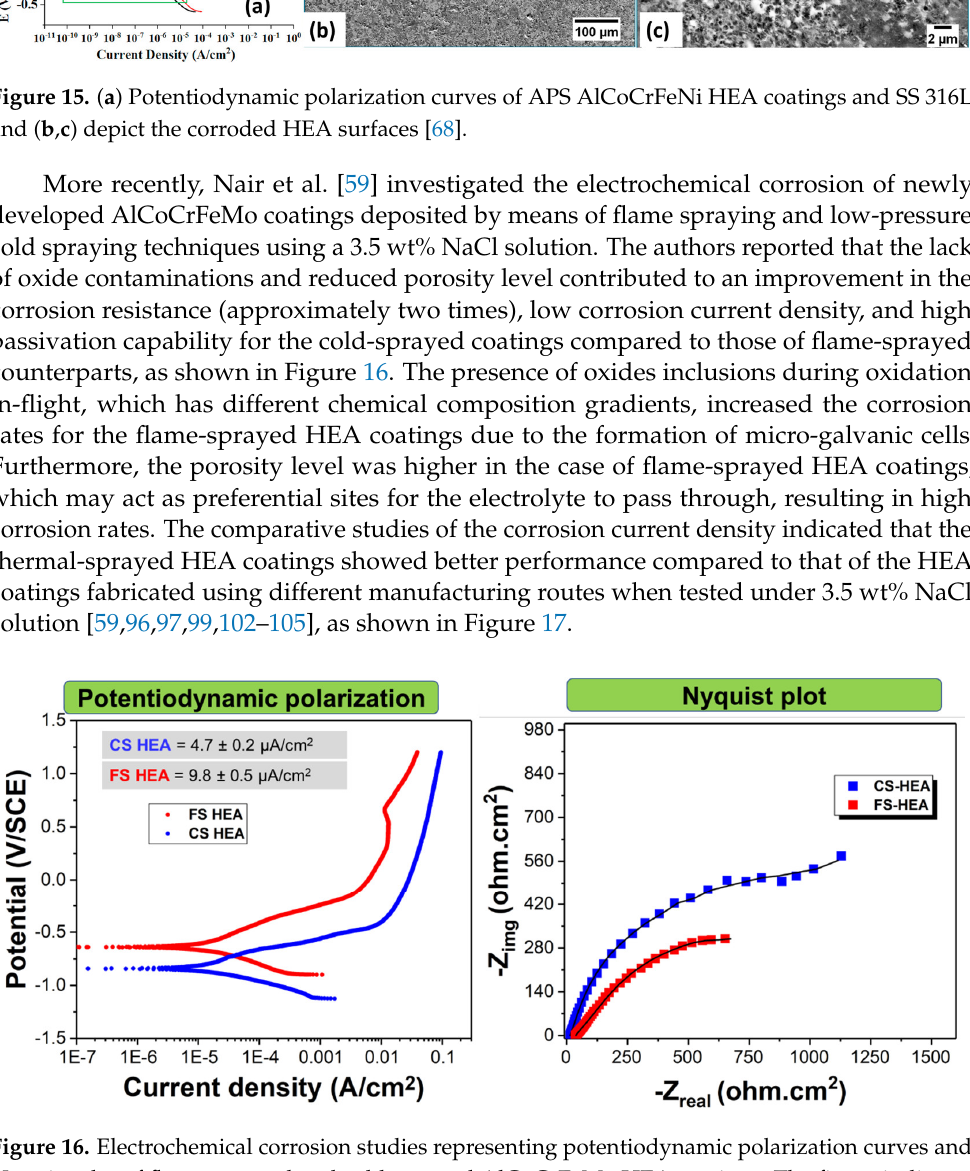
Figure 17. A comparative assessment of corrosion current density for thermally sprayed HEA coat- ings with other HEA coatings fabricated using different methods under 3.5 wt% NaCl solution [59,96,97,99,102–105]. The thermal-sprayed HEA coatings showed lower corrosion rates compared to stainless steel 316L and other HEA coatings. GTAC is gas tungsten arc cladding, CS is cold spray- ing, FS is flame spraying, HVOF is high-velocity oxy-fuel, APS is air plasma spraying, and LC is laser cladding. 4.3. Oxidation Behaviour Although the performance of HEA coatings against corrosion was better than tradi- tional materials, studies on the oxidation behavior of thermal-sprayed HEA coatings were also shown promise. The literature investigated oxidation response on thermal-sprayed HEA coatings that were similar to that of electrochemical corrosion. The studies on oxi- dation response are crucial for thermal-sprayed HEA coatings that can be served in ele- vated temperature applications. Hsu et al. [29,106, 107] fabricated HEAs based on the fam- ily of non-equimolar NiCo 0.6 Fe 0.2 Cr x Si z AlTi y coatings using APS, HVOF, and warm spray- ing (modified HVOF technique). The alloy coatings development strategy aiming at achieving a clearly beneficial property combination, which is required for the insertion of